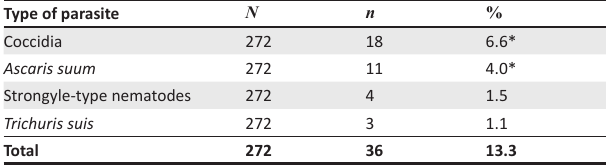
TABLE 1: Overall prevalence of gastrointestinal parasites in pigs in Burayu